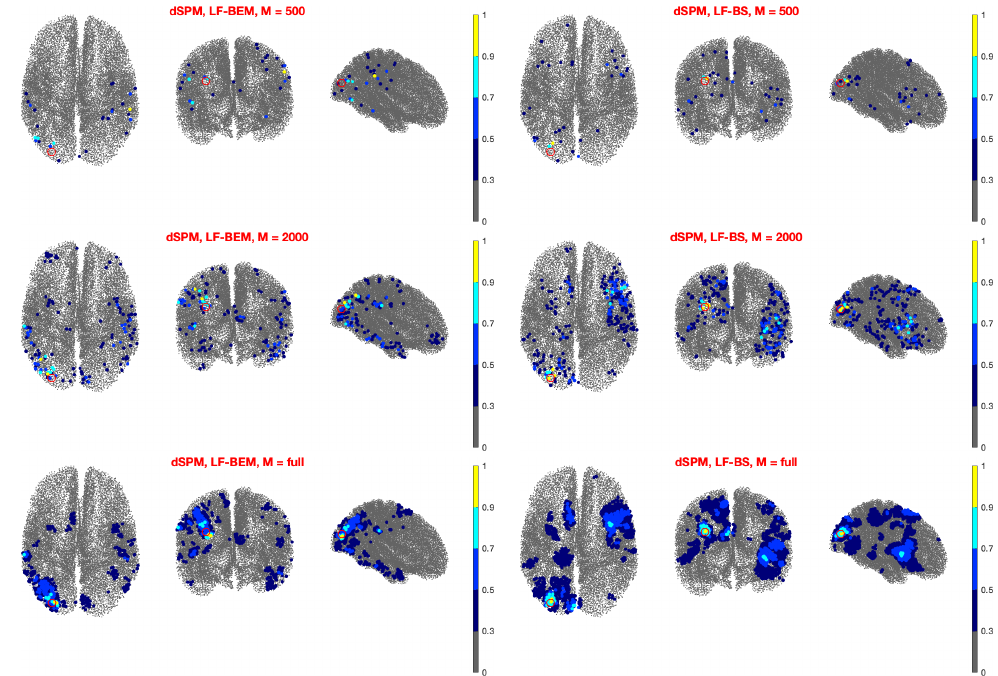
Figure 13. Right Visual evoked field: The intensity of the estimated sources, averaged over N = 10 runs, at 90 ms obtained using dSPM with M = 500 random points (first row), M = 2000 (second row) and the full source space (third row) for LF-BEM (left column) and LF-BS (right column). The red circle represents the dipole fitted using